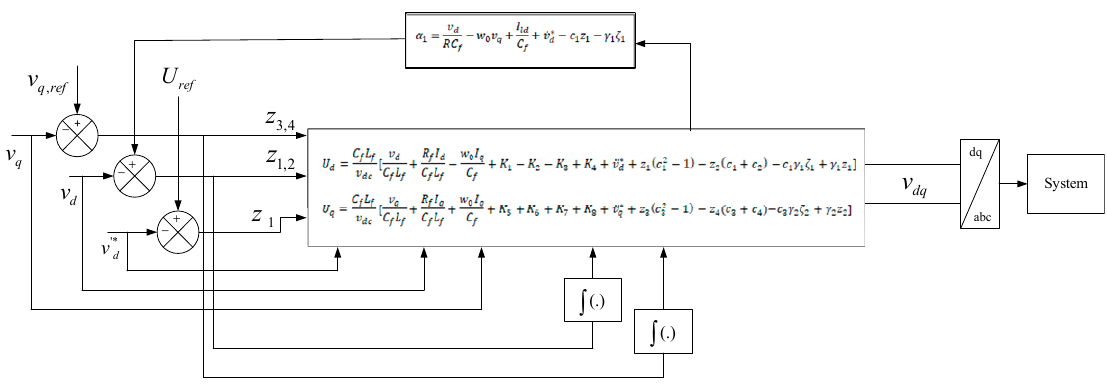
Figure 3. Lock diagram of Integral backstepping Controllor.